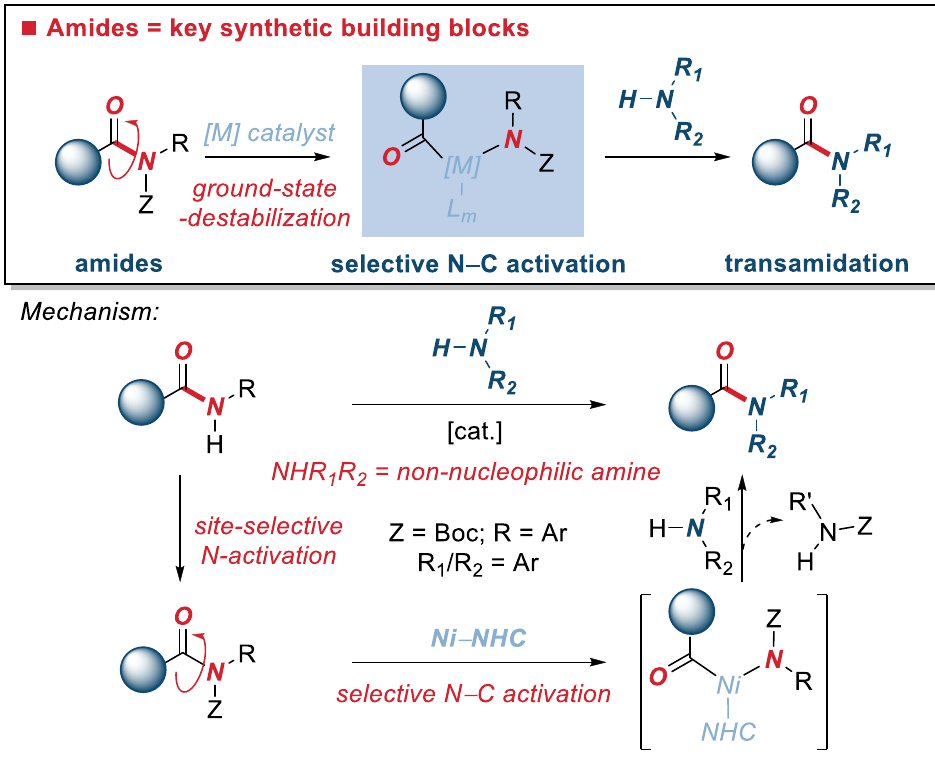
Figure 1. Transamidation of N-activated amides by selective N–C(O) cleavage.